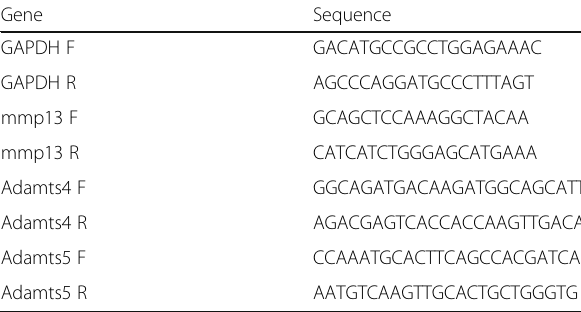
Table 2 RT-PCR primer